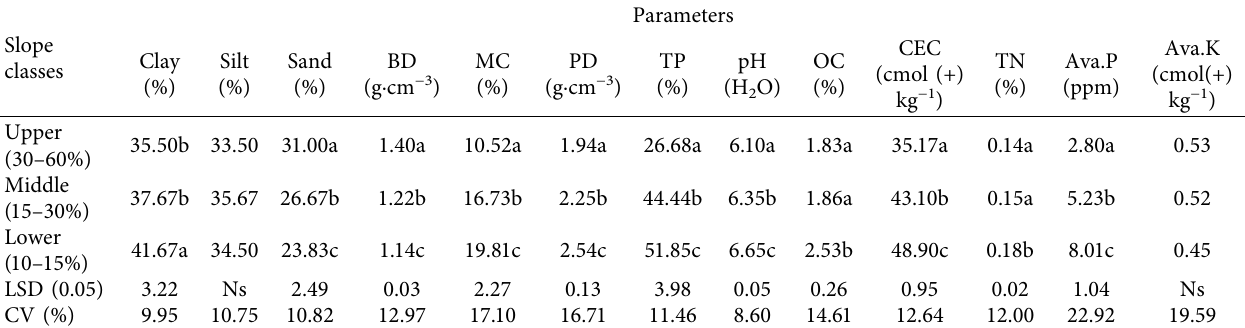
Table 2: Effects of slope gradient on selected soil physicochemical properties in the study